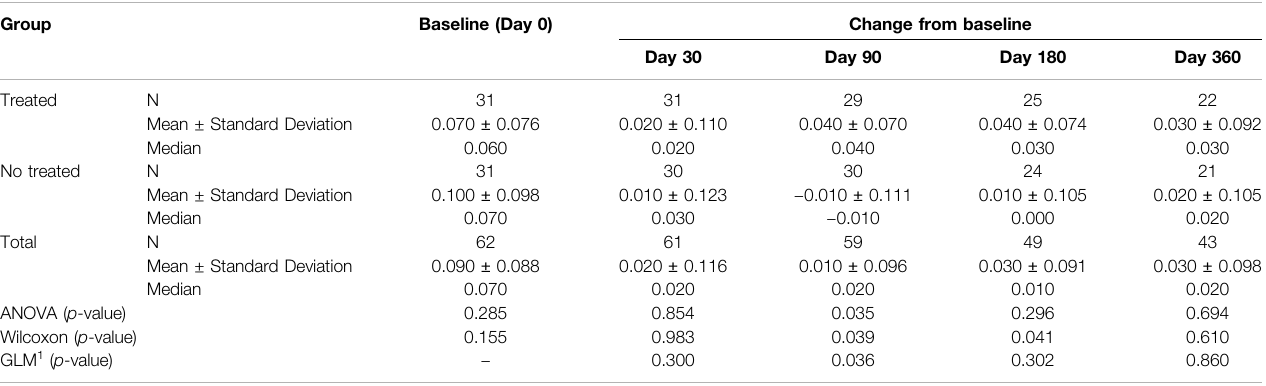
TABLE 4C | (part 3 of 5). GAIT parameters cohort without outliers. Peak Hip Rotation. General Linear Model with Peak Hip Rotation change from baseline as dependent variable, treatment as factor, and Peak Hip Rotation baseline value as covariate.